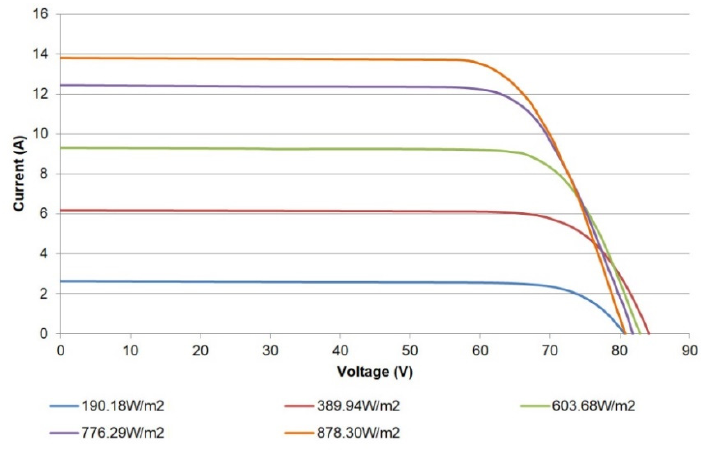
Figure 20. I-V curves of PV generator. Figure 20. I ‐ V curves of PV generator.